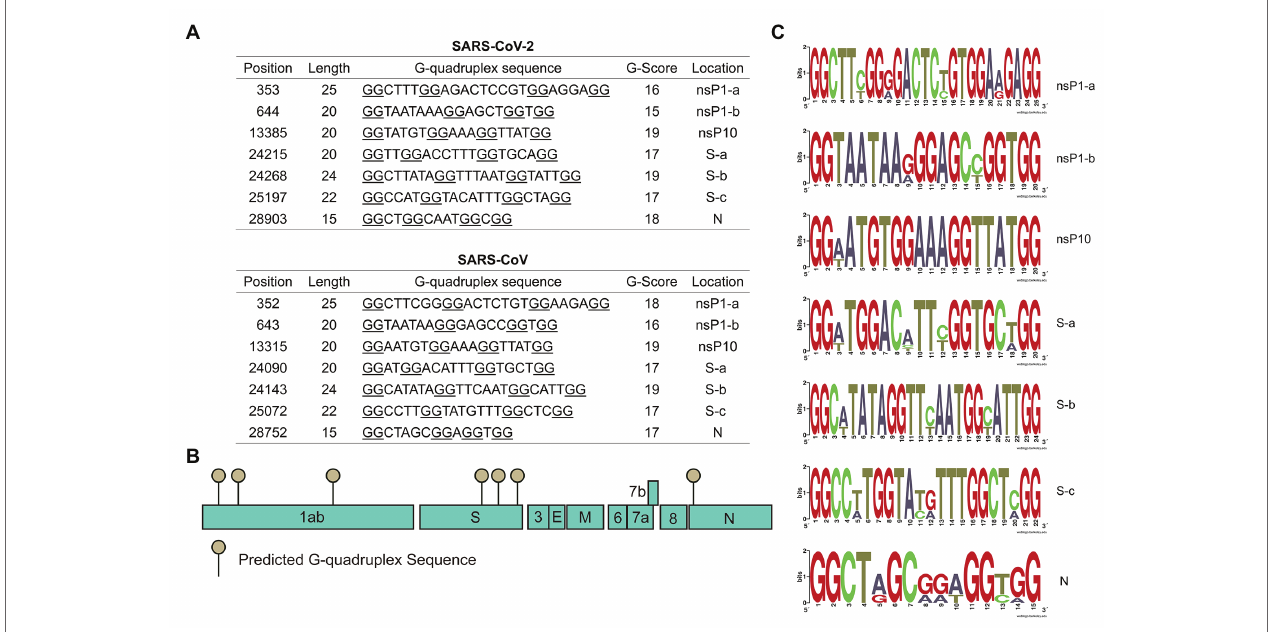
FIGURE 2 | Severe acute respiratory syndrome-related coronavirus (SARSr-CoV) possesses G-quadruplexes. (A) Conserved G-quadruplex sequences in severe acute respiratory syndrome coronavirus 2 (SARS-CoV-2) and SARS-CoV genomes. (B) A model of the conserved G-quadruplex forming sites in SARS-CoV-2 genome. (C) Sequence logos formed by G-quadruplex sequences in typical